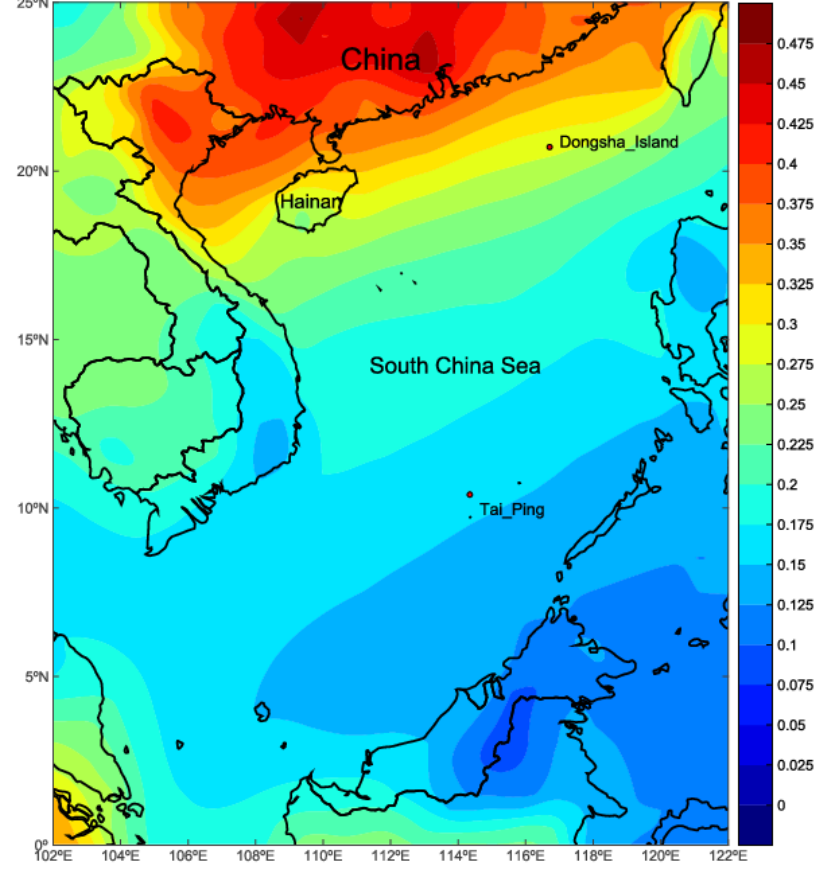
Figure 2. Spatial distribution of mean values of the 550 nm MERRA-2 AOD over the SCS in the period of 1980–2020.